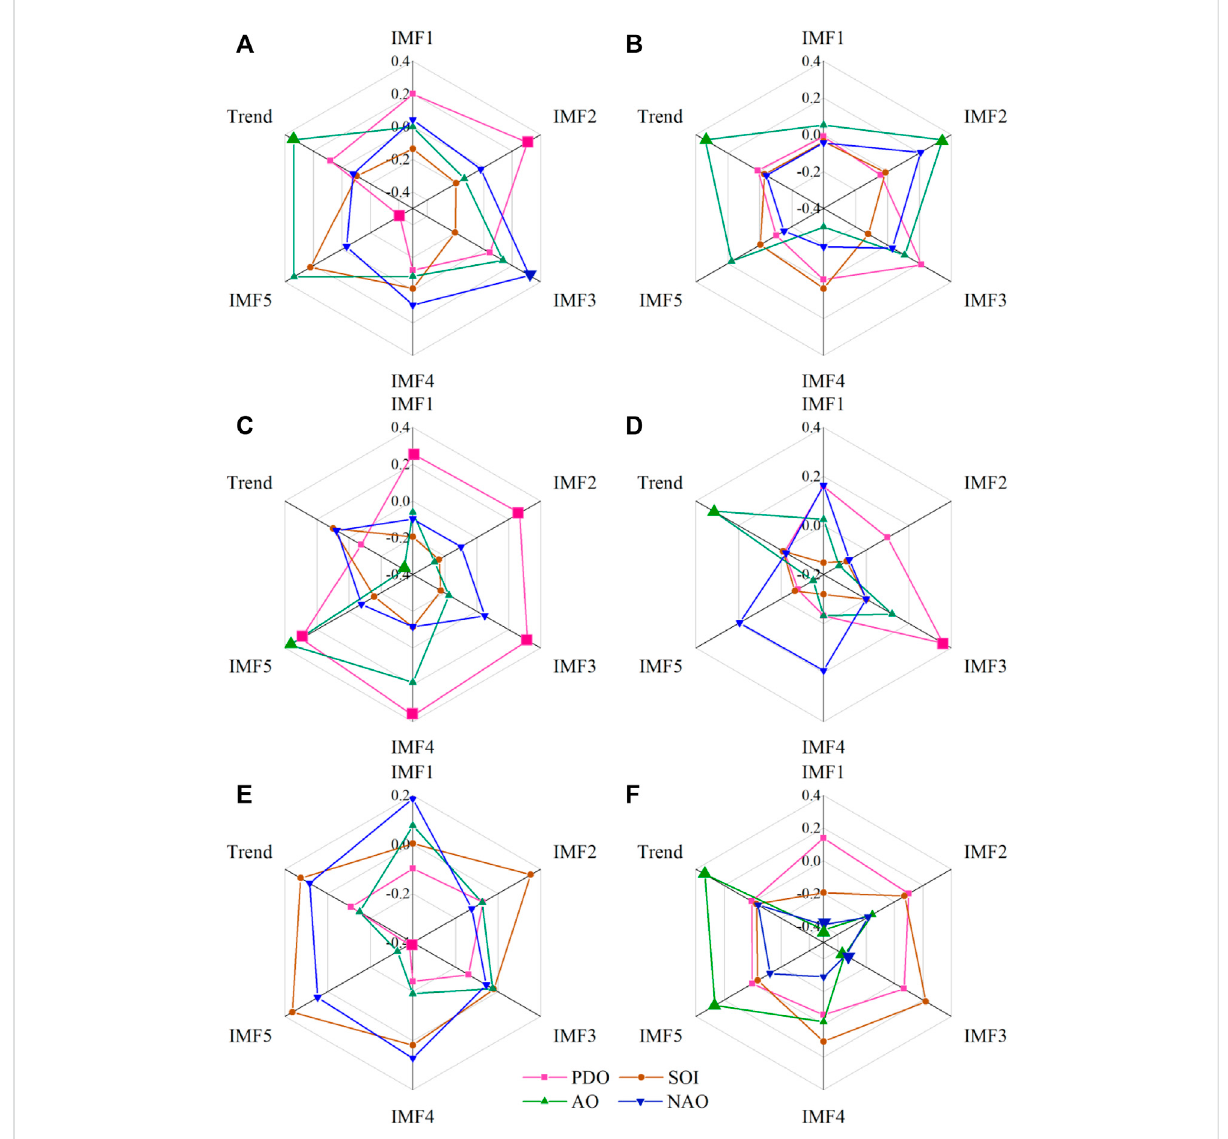
FIGURE 10 Correlationsofthefouroceanicoscillationindexeswiththecomponentsoftheprecipitation(left)andtemperature(right)aftertheEEMDinthe PCA (A,B) , NAm (C,D) , NAf (E,F) . The larger dots indicate the values passing the signi fi cance test at the 99% con fi dence